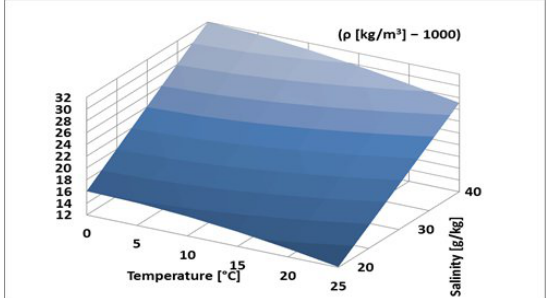
Fig. 1. Density ( ρ [kg/m 3 ]− 1000) vs. temperature [°C] and salinity [g salt/kg water] at atmospheric